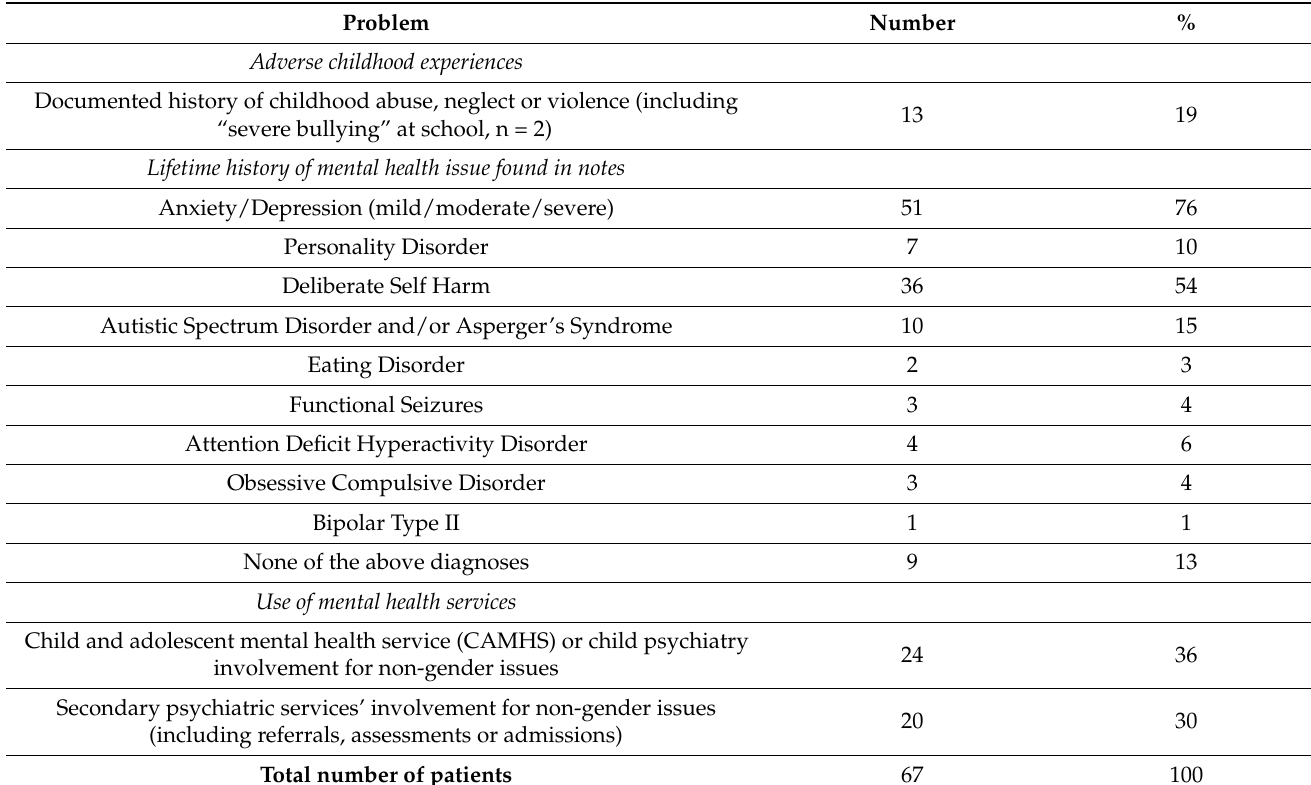
Table 3. Adverse childhood experiences, lifetime history of mental health problems and use of mental health services for non-gender related